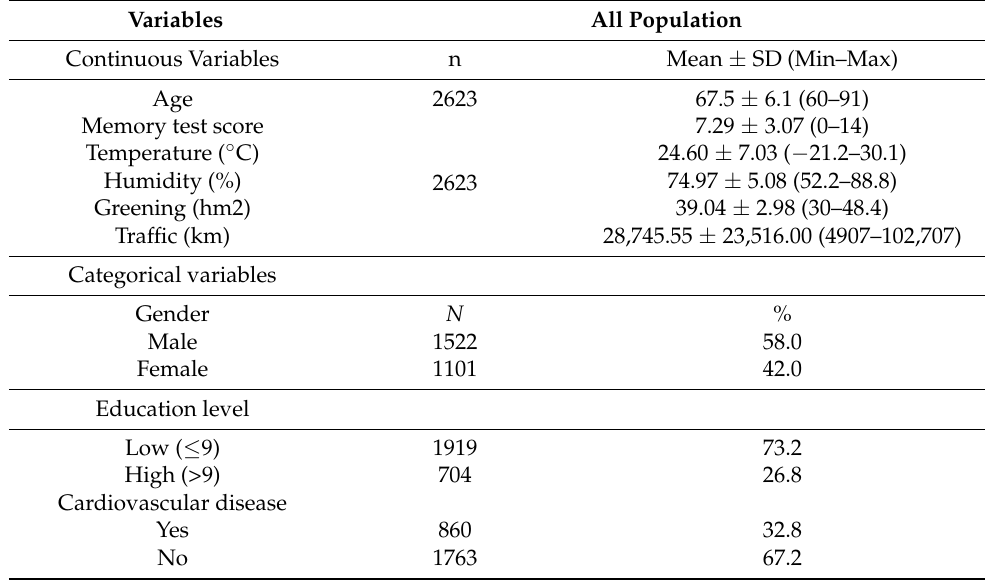
Table 1. Descriptive statistics of continuous and categorical